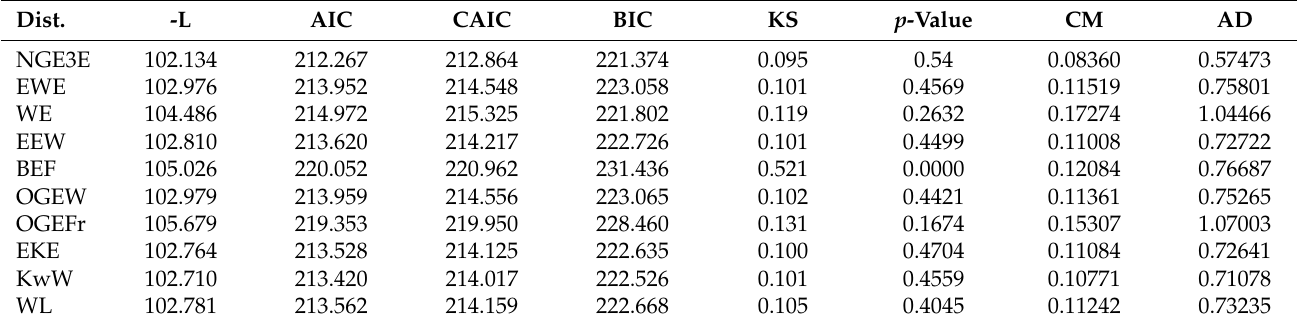
Table 5. GFMs of CMs for guinea-pig data.